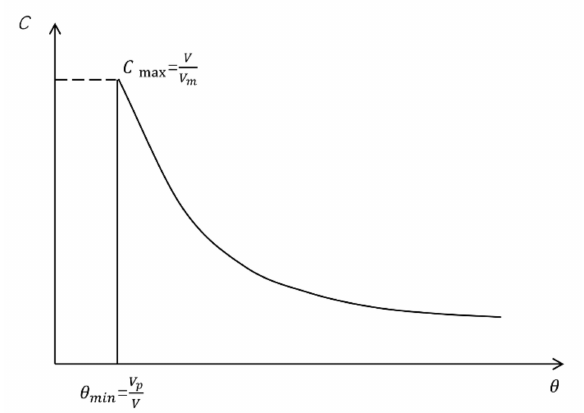
Figure 1. RTD curve of typical combined model [13].